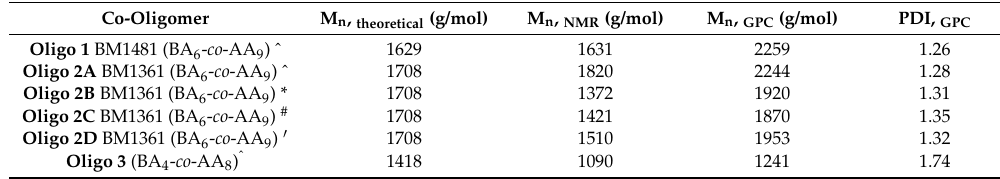
Table 1. Characterization of co-oligomer with NMR and GPC.